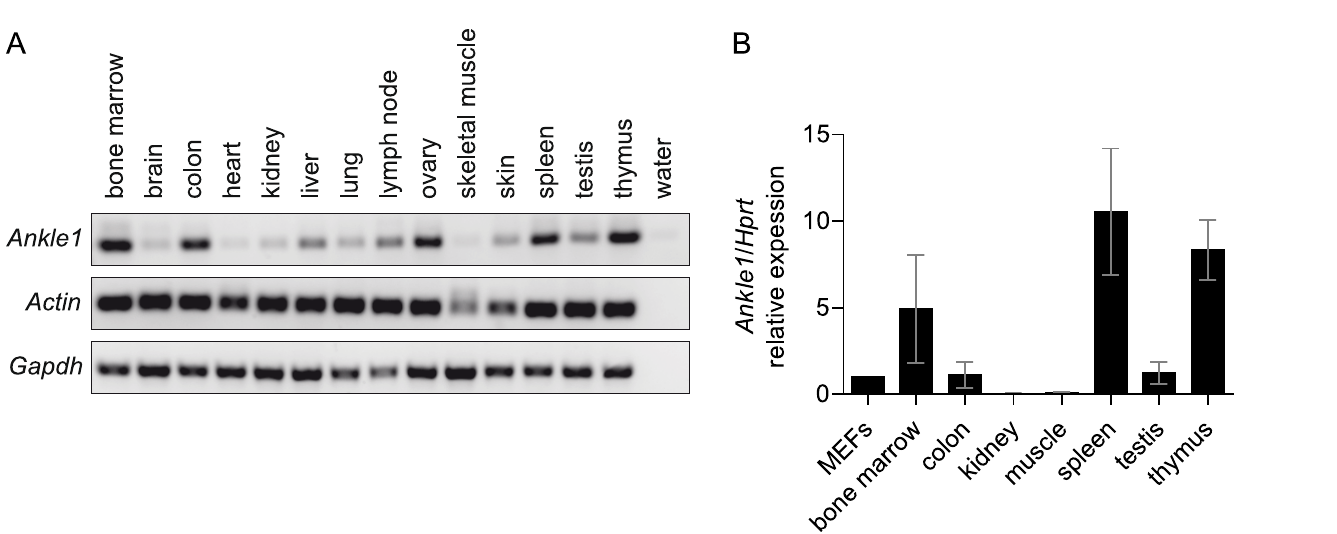
Fig 1. Expression of Ankle1 in murine tissues. (A) Representative end point PCR from tissue cDNA, Actin and Gapdh serve as loading control; (B) Quantitative real time PCR, samples are normalized to Ankle1 expression in primary mouse embryonic fibroblasts (MEFs), 3 (cid:1) n (cid:1) 5, error bars: standard